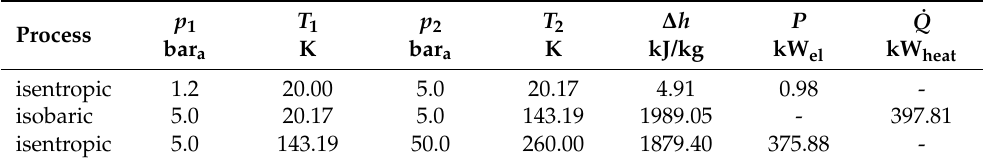
Table 4. Arrangement: liquid low-pressure pump, heat exchanger/vaporizer, gaseous high-pressure pump; isentropic and isobaric change of state for the consideration of the required power, divided into electrical power and heat